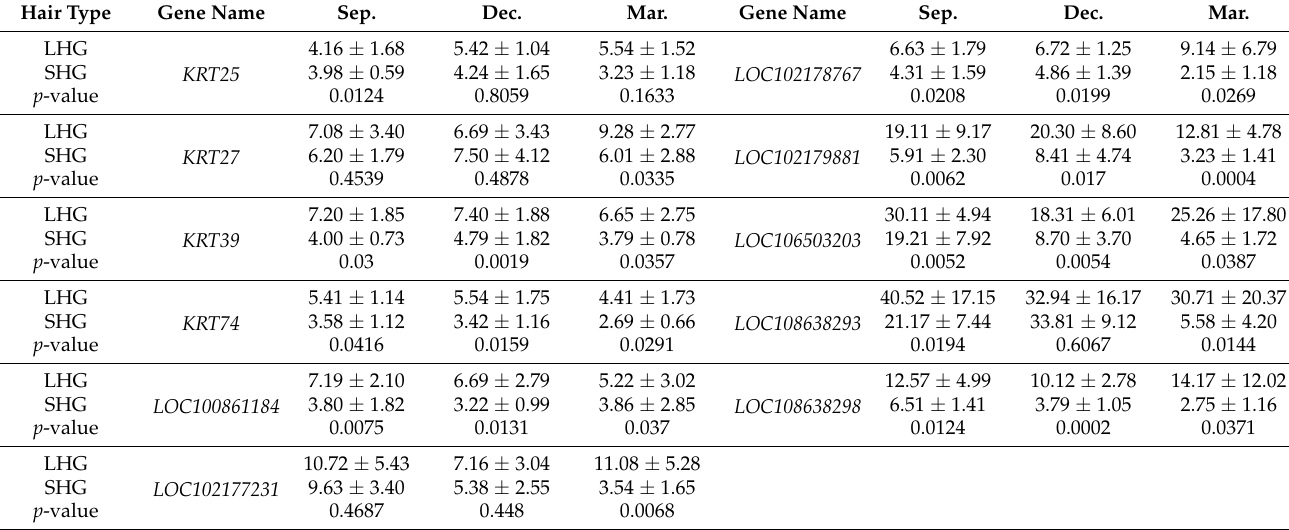
Table 4. Statistical table of the relative expression of the candidate